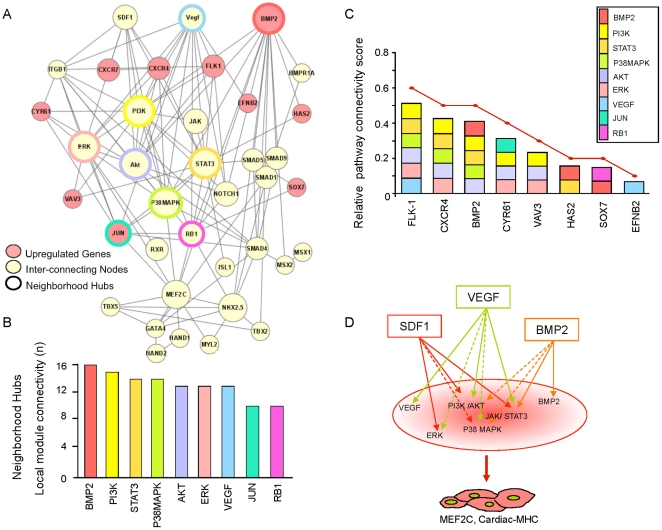
Prioritization of network hubs for cardiogenic induction.(A) A neighborhood of genes, cross-referenced with the Mouse Genome Informatics (MGI) knockout-based cardiac phenotype database, was independently established by Ingenuity as the most prioritized sub-network of the integrated cardiogenic framework. Nodes in the network are pink (upregulated pro-cardiac genes) or yellow (database-predicted direct interacting genes). Hubs are defined as highly connected nodes (genes) outlined in the network by colored circles. (B) Local module connectivity was defined for each of the network hubs as the total number of node connections they establish. (C) A relative pathway connectivity score (red, line graph) was calculated for the upregulated pro-cardiac genes, defined as the ratio of the number of hubs each cardiac gene is connected to over the total number of hubs available in the sub-network. (D) The integrated signaling model predicts the behavior of the network in the context of a triple treatment that would collectively target all integrating signaling highways. Co-stimulation of the SDF-1/CXCR4, VEGF/Flk-1 and BMP2/BMP2r axes is predicted to simultaneously activate all network hubs and empirical cardiac genes. Biological output will be quantified via nuclear transcription factors (i.e., Mef2C) and reporter assays (cardiac-MHC–Lac Z) as surrogates for de facto cardiogenic specification.